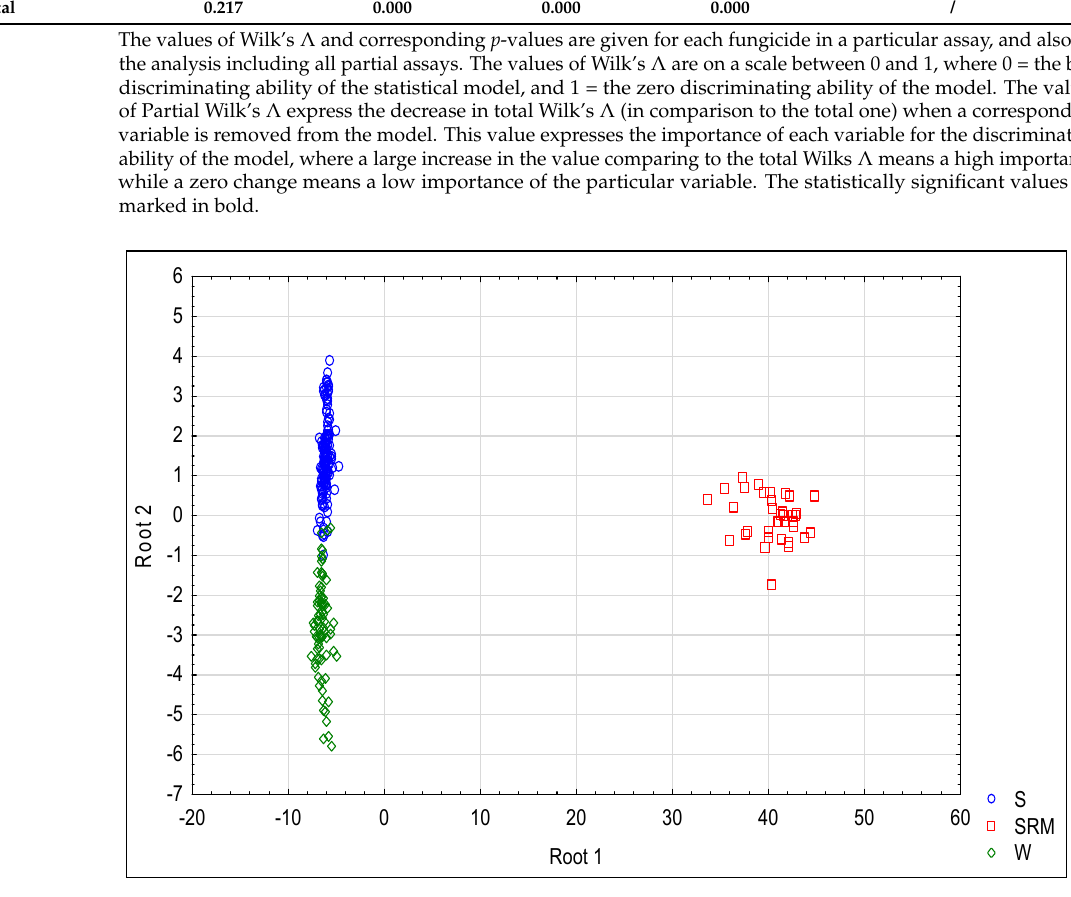
Figure 1. Similarities between the responses of P. cactorum isolates to metalaxyl in the mycelial growth inhibition assay. The results of canonical discriminant analysis depict the differences ac- cording to canonical root 1 as only being associated with resistance to metalaxyl, and does not differentiate groups W and S. The differences according to root 2 depict the component of variability of resistance associated with membership in these two groups. The grouping used: S—isolates from strawberry plants, SRM—isolates from strawberry plants resistant to metalaxyl and W—isolates from woody plants.